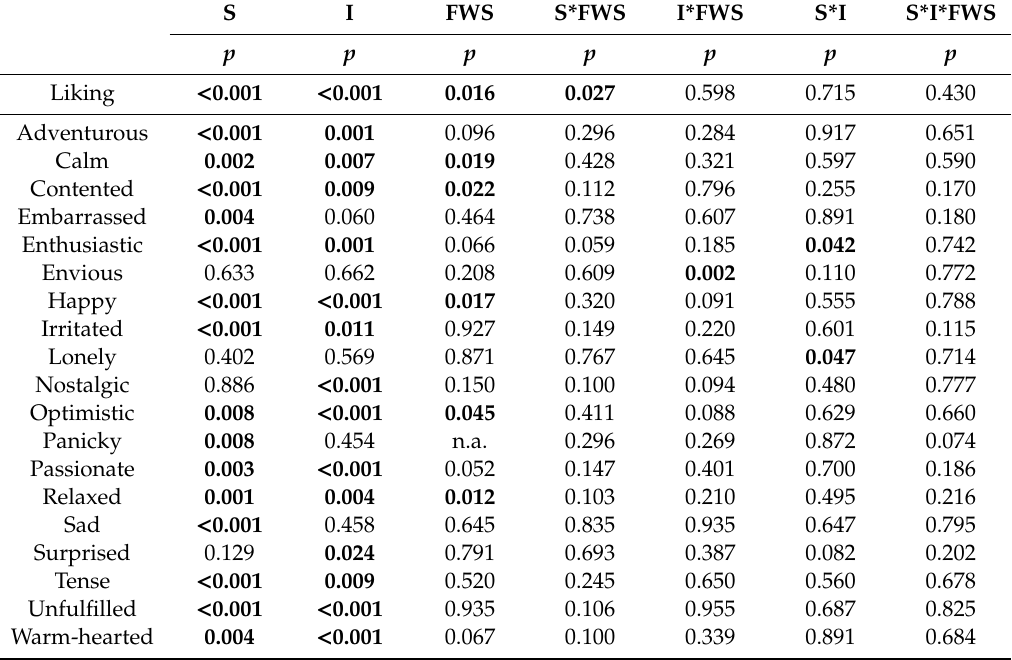
Table 3. Results of the Repeated Measures ANOVA investigating e ff ects of sample (S), information (I) and fine wine segments (FWS) on liking and reported product-evoked emotions for Study